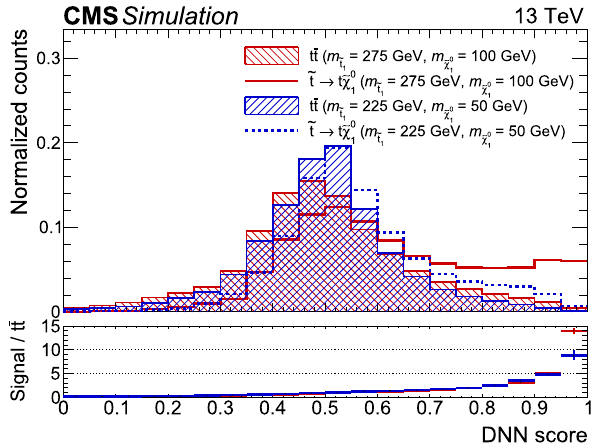
Fig. 5 Normalized DNN score distribution comparing the signal and the tt background in the signal region for two mass hypotheses: m 50 (100)GeV and m (cid:2) t1 = 225